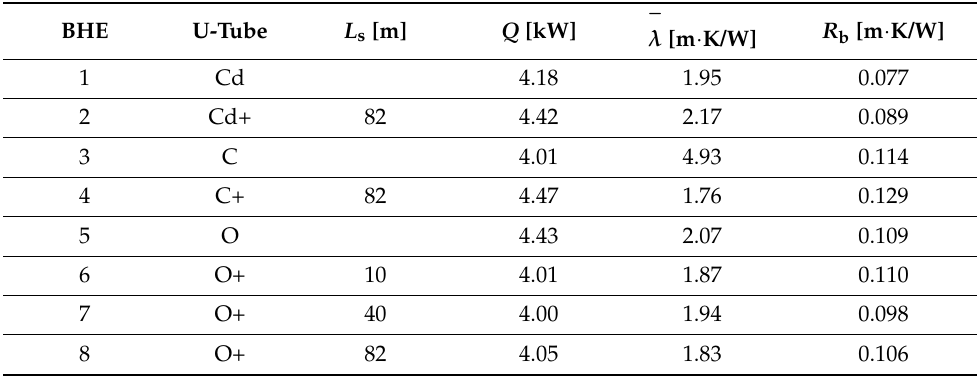
Table 1. Summary of configurations and analysis results for conventional Thermal response tests